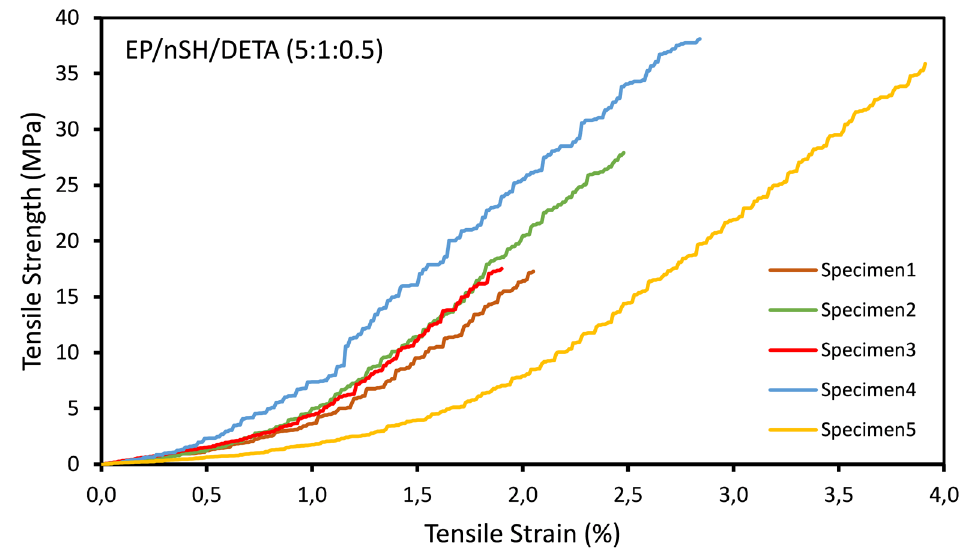
Figure 8. Stress- strain curves for the EP/n-SH/ DETA (5:1:0.5) system reacted at 25 o